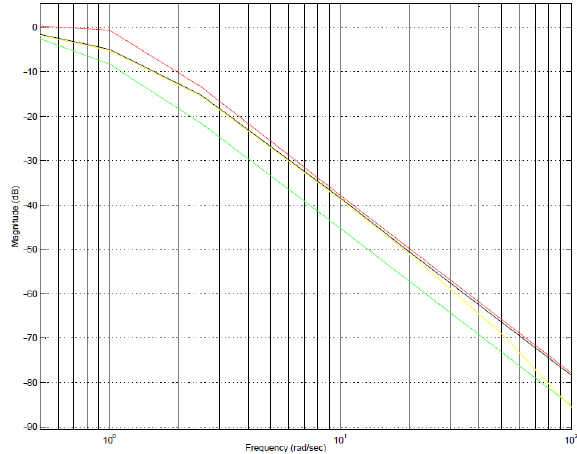
Figure 14. Pre-filter shaping for the vertical